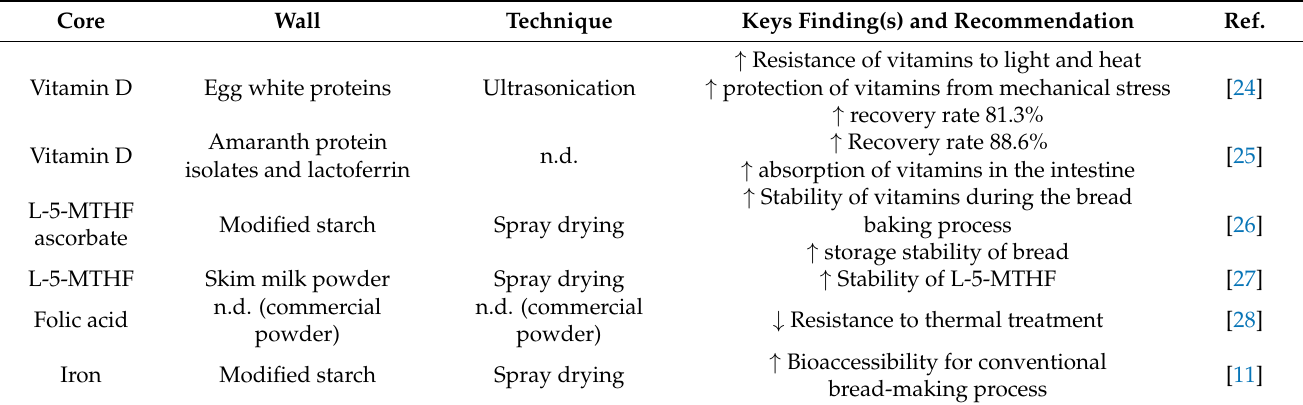
Table 2. Encapsulation of vitamins and minerals for bread